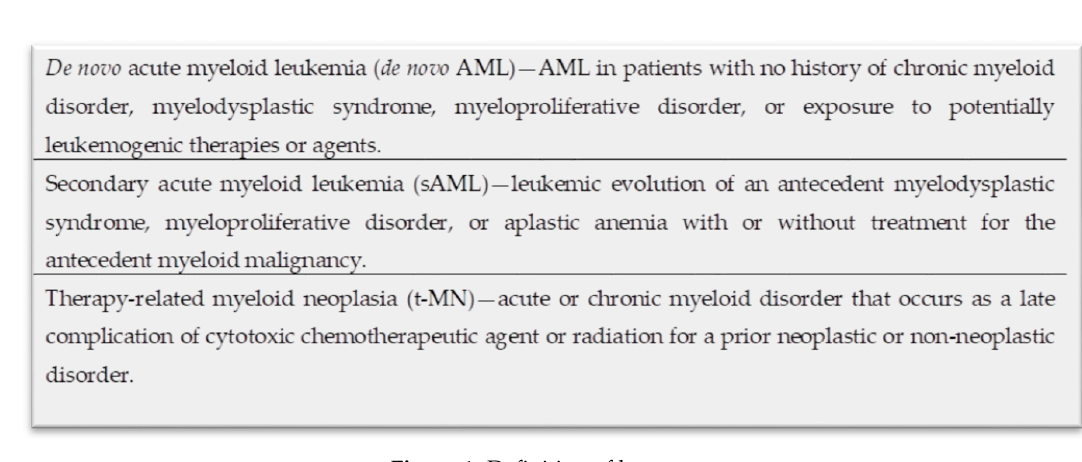
Figure 1. Definition of key terms.